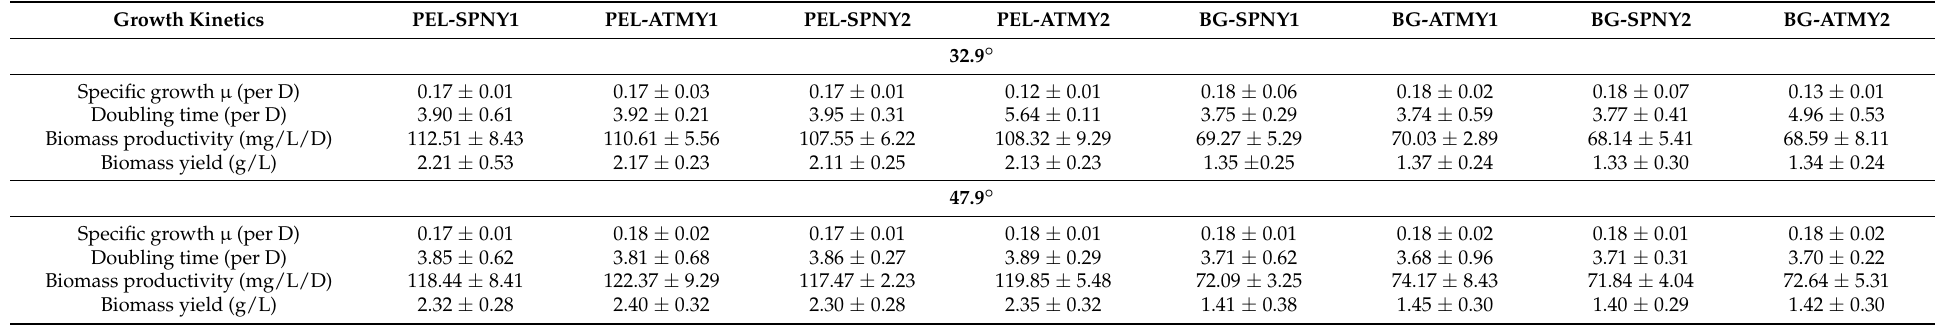
Table 1. Specific growth, doubling time, biomass productivity, and biomass yield of C. pyrenoidosa in PEL and BG-11 during the 20th day of the cultivation